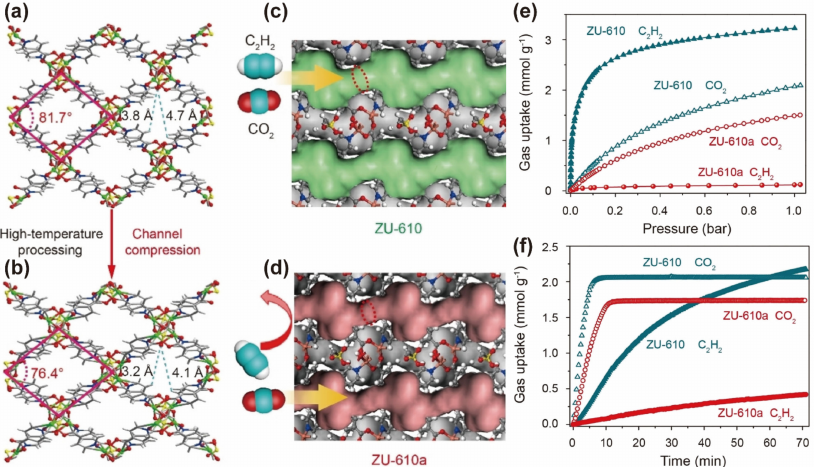
Figure 10. ( a , b ) The structures and rhombic channel of ZU-610 ( a ) and ZU-610a ( b ). ( c , d ) The 1D channel of ZU-610 ( c ) and ZU-610a ( d ). ( e ) Sorption isotherms of C 2 H 2 and CO 2 . ( f ) Gas adsorption of C 2 H 2 and CO 2 versus time at 298 K, 1 bar. Reproduced with permission from Cui et al., Angewandte Chemie International Edition; published by John Wiley and Sons, 2022